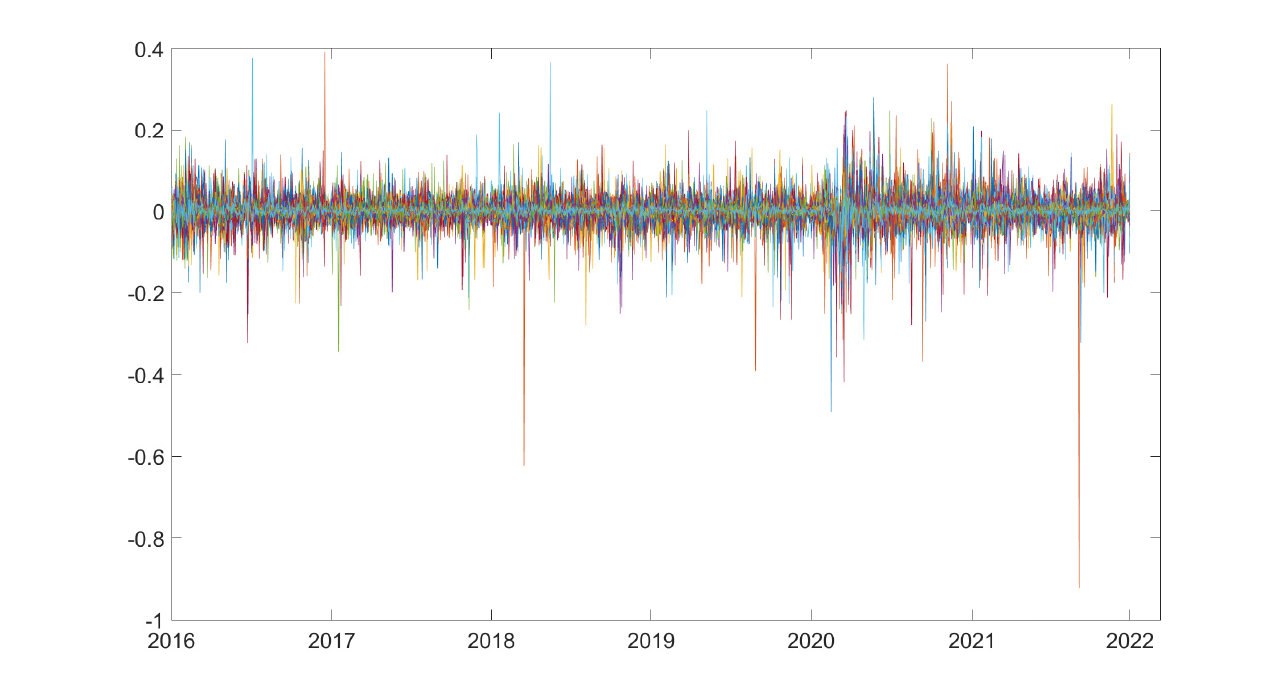
Figure 3. Returns of the S&P Europe 350 index constituent stocks from January 2016 to December 2021. Source: Authors’